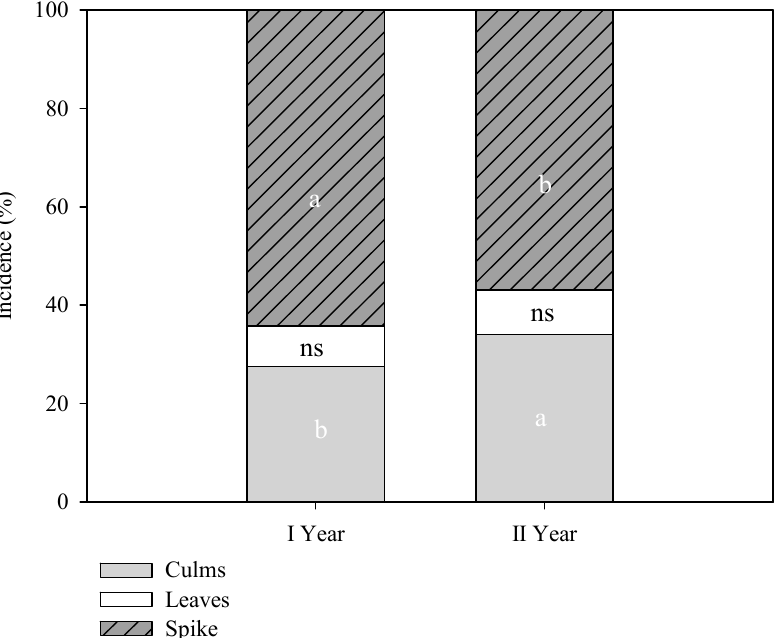
Figure 2. Culms, leaves and spikes percentage of barley as affected by nitrogen fertilization levels (not fertilized = N0; fertilized with 20 kg N ha − 1 = N20; fertilized with 40 kg N ha − 1 = N40 and ferti- lized with 60 kg N ha − 1 = N60). Different letters indicate significant differences according to Dun- can’s test ( p < 0.05). ns = non-significant.